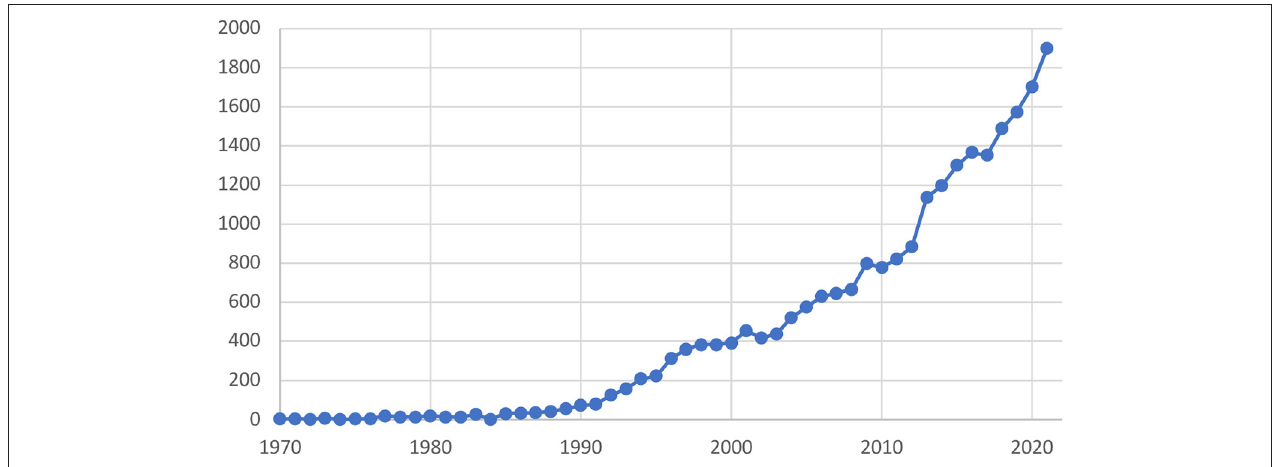
FIGURE 1 | Yearly frequency of publications mentioning “heart rate variability” in